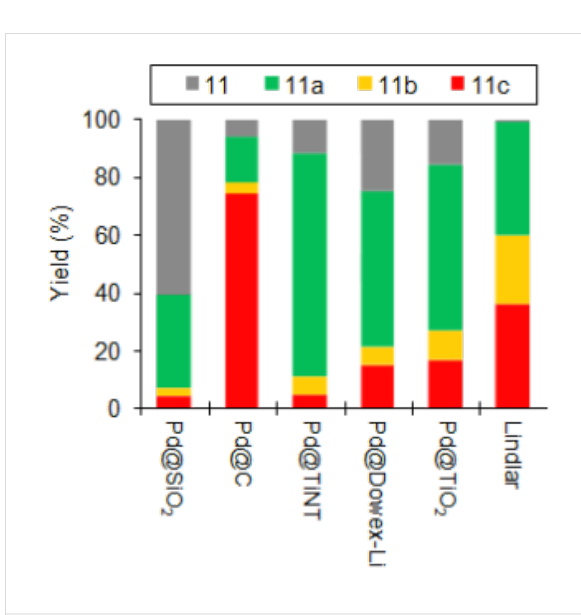
Figure 12: Continuous-flow hydrogenation reaction of 11 over packed- bed catalysts. Adapted with permission from [137], © 2016 John Wiley and